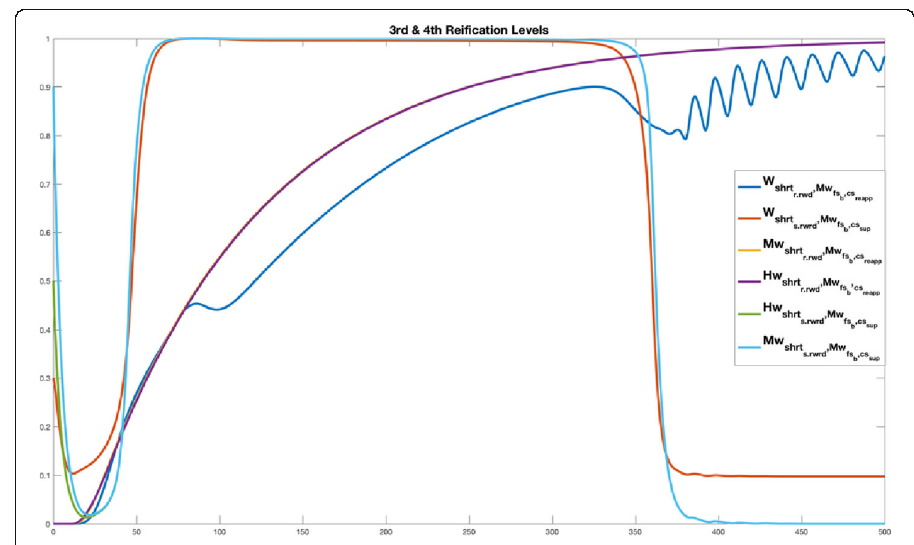
Fig. 6 Third- and fourth-order adaptation states over time